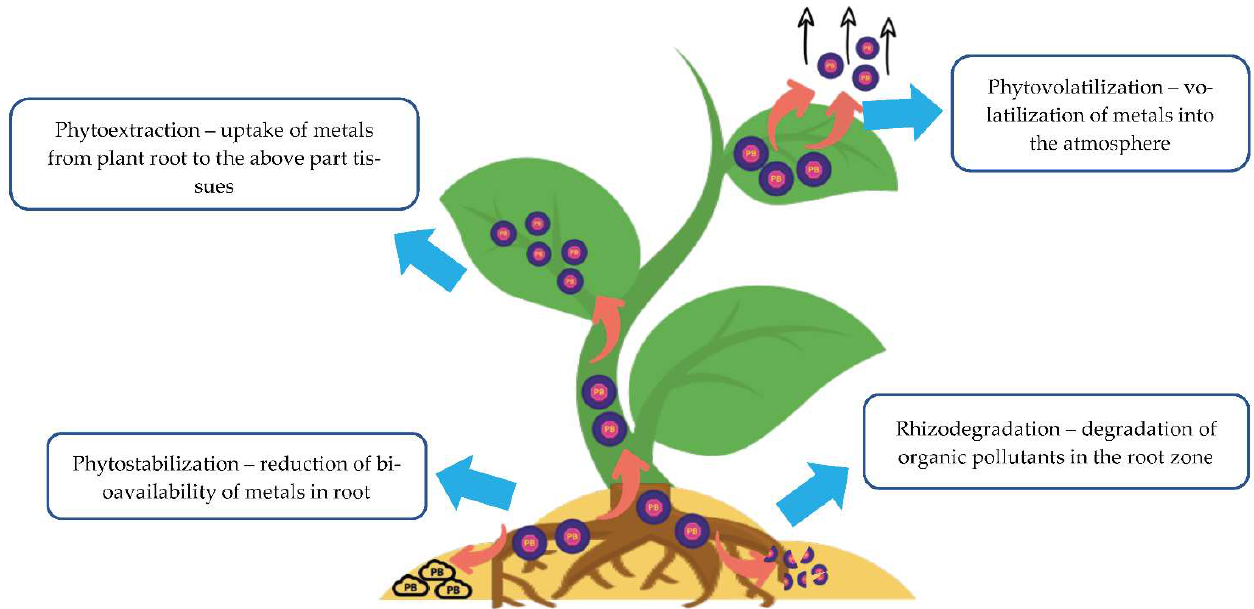
Figure 1. Mechanisms involved in the phytoremediation process.